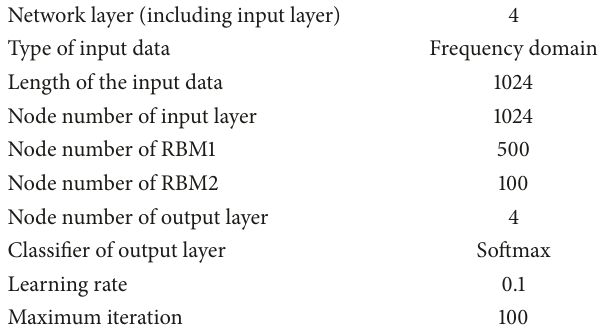
Table 1: Parameters of